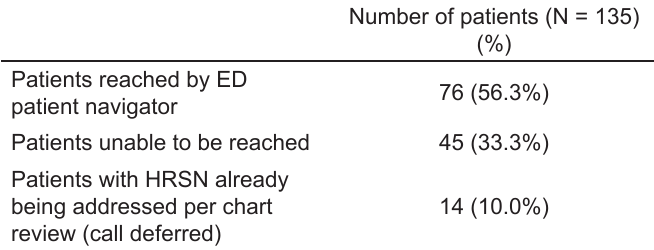
Table 4. Outcome of telephone calls made by patient navigators in the emergency department.